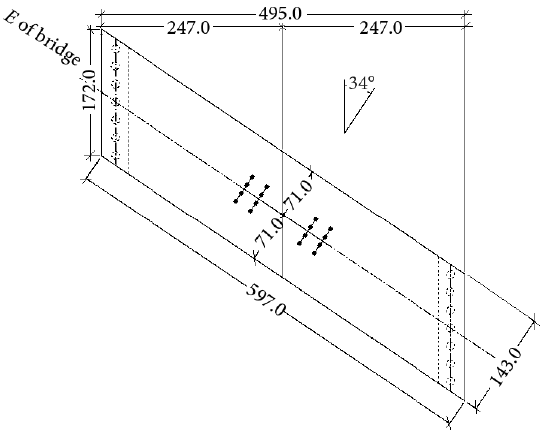
Fig. 8. Wheel loads applied at mid-span (in mm)